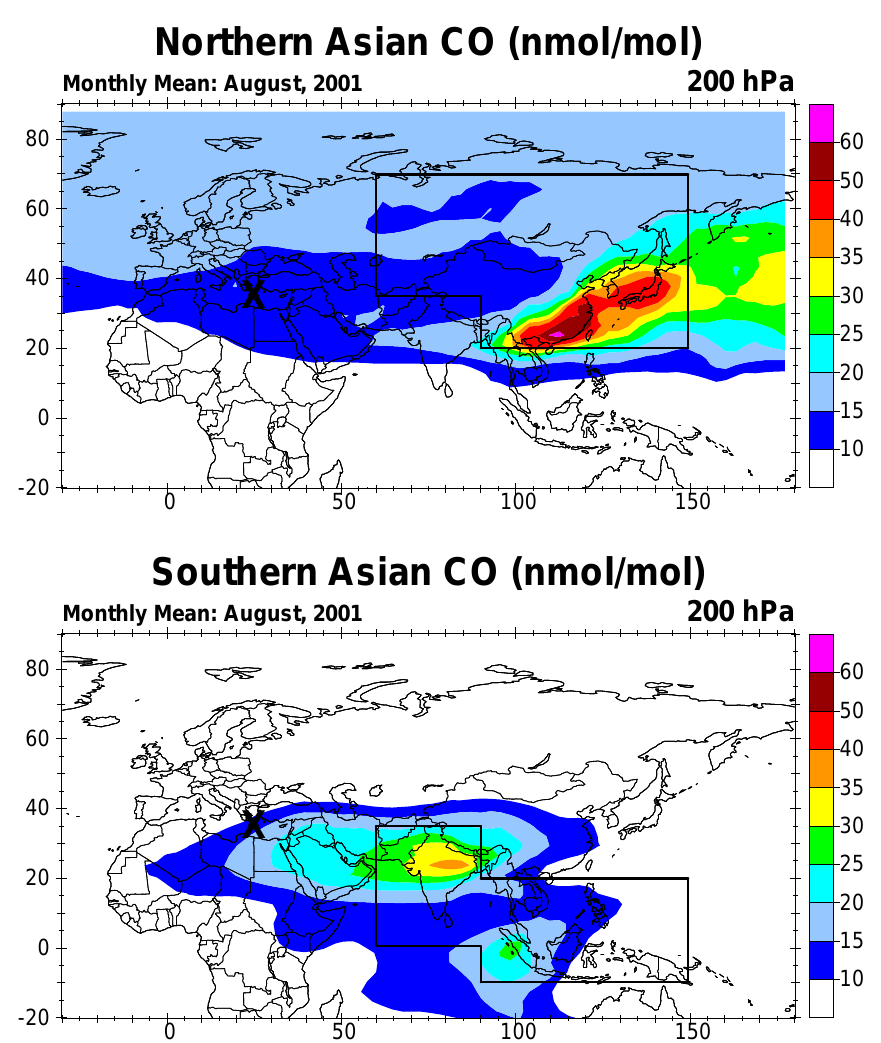
Fig. 43. Mean simulated distributions of a northern Asian and a southern Asian CO tracer at 200hPa averaged over August 2001; the heavy black lines indicate the boundaries of where emissions are included for each of the two tracers (based on Lawrence et al., 2003a, copyright 2003 by the European Geophysical Union, modified with permission; an animation of the outflow is available in the supplementary material of Lawrence et al., 2003a, http://www.copernicus.org/EGU/acp/acp/3/267/acp-3-267